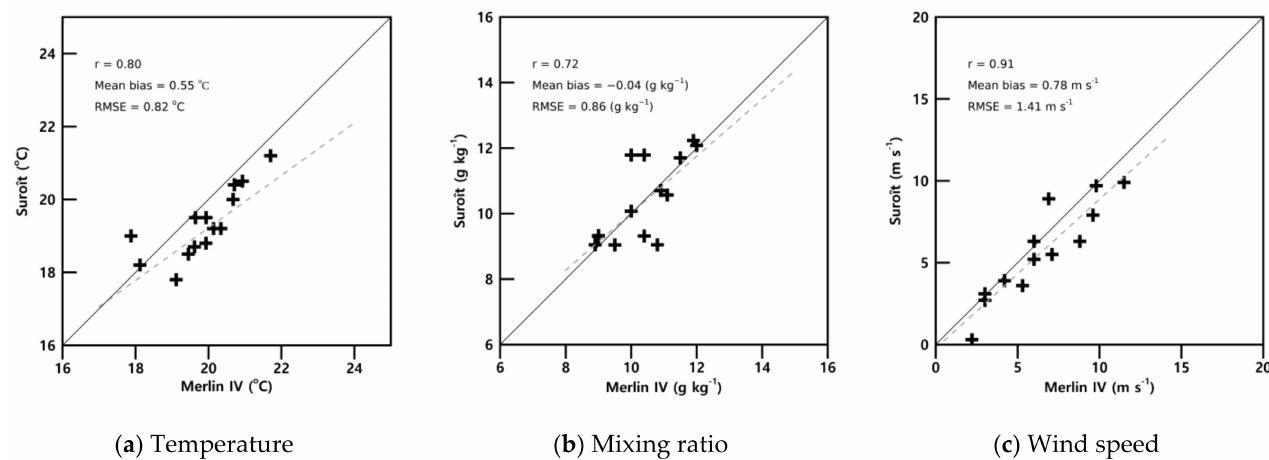
Figure 7. Comparison of ( a ) temperature, ( b ) mixing ratio and ( c ) wind speed measured at 10 m on the ship with aircraft-based